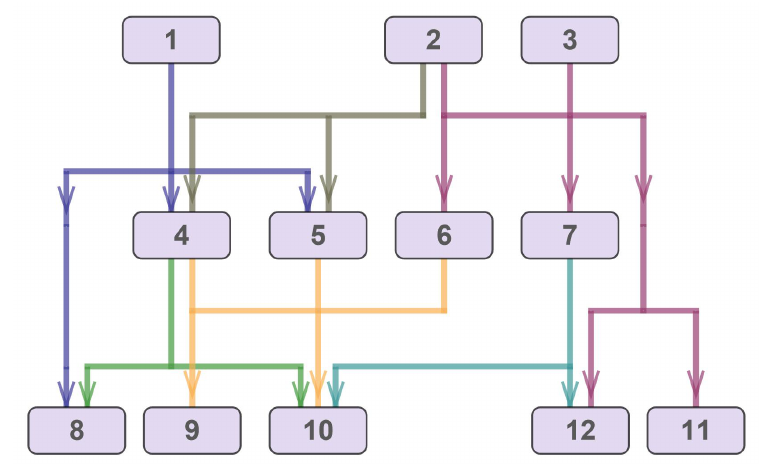
Figure 1. An example of the layering of a hierarchical hypergraph with orthogonal hyperedges according to the accepted rules.